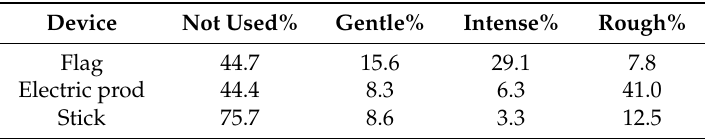
Table 2. The use of devices when unloading cattle.